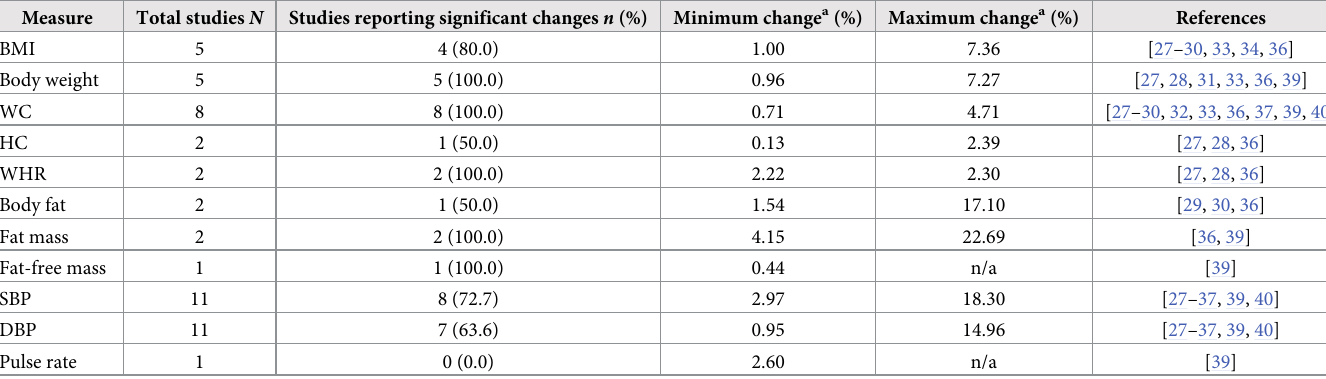
Table 2. Changes in anthropometry and physical measures.